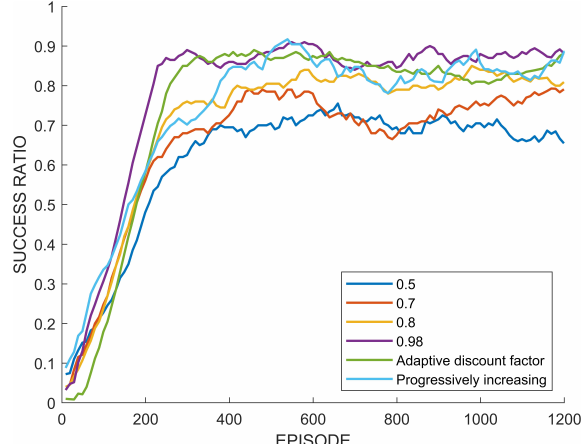
Figure 12. Success rate of path planning in the episodic task.